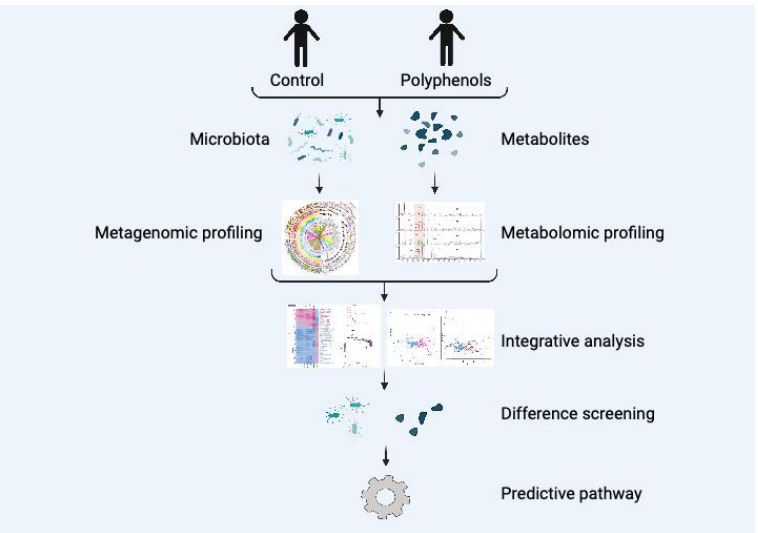
Figure 4. Combining microbiome and metabolomics to investigate the bioactivity of plant polyphenols.